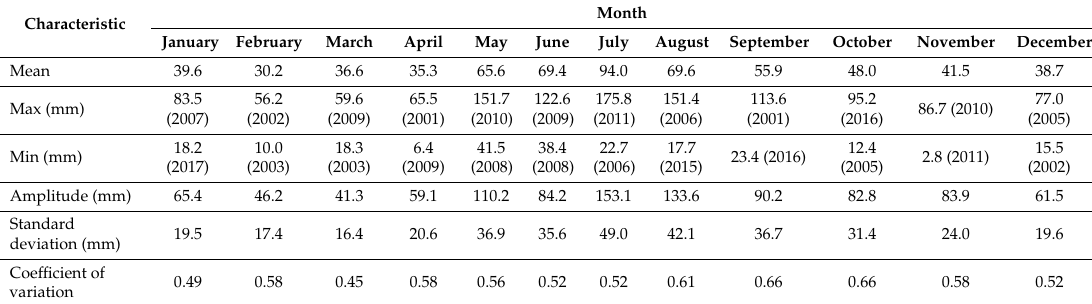
Table 1. Selected characteristics of monthly precipitation totals averaged across Poland in 2001– 2018.